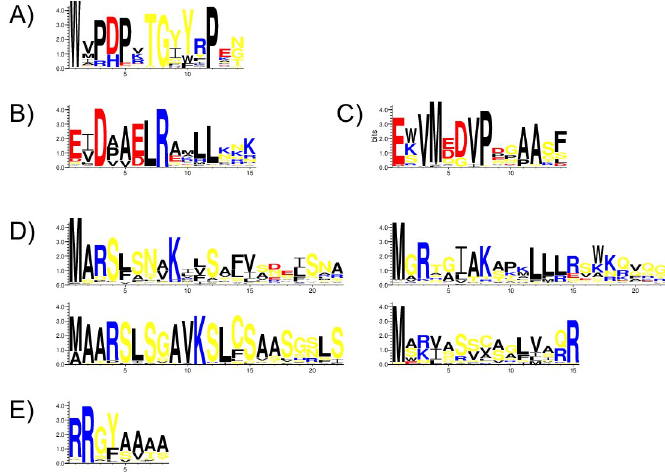
Fig 1. Conservation of the W-motif and other motifs in LEA3 proteins. A) W-motif. B) DAELR motif. C) EDVMP motif. D) N-terminal motifs (MARS, MAARS, MGRX and M[AS][RK]). E) RRGYA 4 motif. Amino acids are color- coded by their group type. Blue—positively charged (Lys, Arg, His); red—negatively charged (Asp, Glu); black— hydrophobic (Ala, Val, Leu, Ile, Pro, Phe, Met), yellow—polar (Gly, Ser, Thr, Tyr, Cys, Asn, Gln). The heights of the amino acids correspond to their level of conservation at that